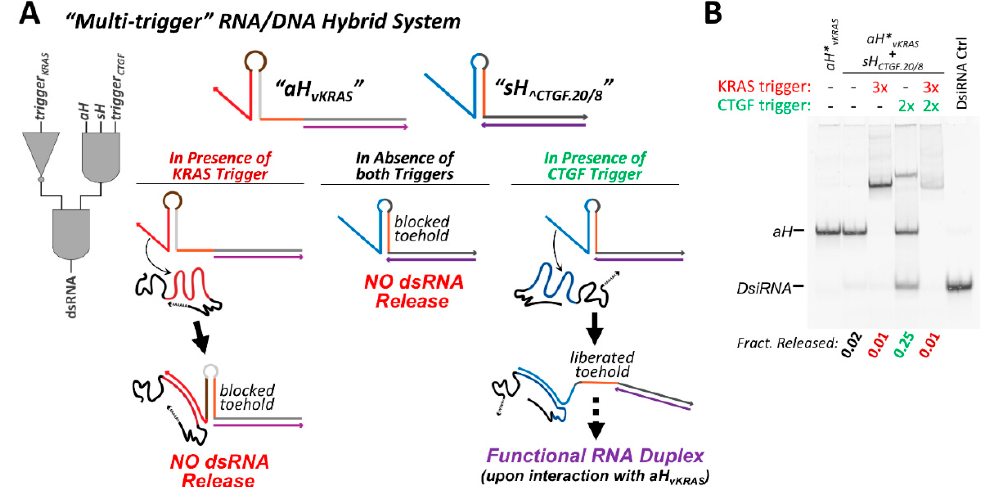
Figure 6. Multi-trigger systems can be composed in which each RNA/DNA hybrid contains a responsive DNA structural element. ( A ) A system comprising a 3-input AND gate and a NOT gate can be constructed by pairing sH ^CTGF.20/8 (activated by the connective tissue growth factor (CTGF) derived trigger) with aH ∨ KRAS (repressed by the Kirsten rat sarcoma proto-oncogene (KRAS) mRNA derived trigger). Co-incubation of the two hybrids results in no interaction. Both hybrids and the CTGF trigger are required for dsRNA release, while the presence of the KRAS trigger will inhibit strand exchange. ( B ) The multi-trigger system was assessed by 10% acrylamide non-denaturing PAGE. The fraction of DsiRNA released is indicated in the gel depicted, in the presence of indicated trigger combinations following 30 min incubation at 37 °C. The sH and aH hybrid were present at equimolar concentration, while the triggers were added at a 2-fold or 3-fold excess, as indicated. In samples when both triggers are present, they were added to premixed hybrids sequentially (KRAS followed by CTGF). The antisense hybrid and DsiRNA control in were assembled using a 5 ′ - AlexaFluor546 labeled antisense RNA strand for the purpose of visualization and quantification.